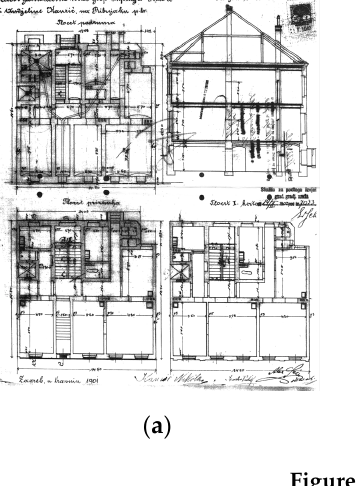
Figure 4. Investigated buildings Ribnjak 44: ( a ) original drawings from the State Archives in Zagreb; ( b ) reconstruction-demolished walls shown in red color State Archives in Zagreb; ( c ) construction of new walls and a lodge [32]. Reproduced with permission from State Archives in Zagreb, 2022.